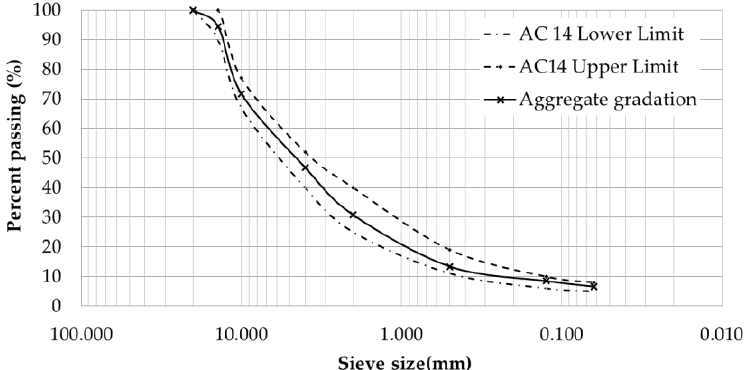
Figure 1. Aggregate gradation of the asphalt concrete with an aggregate size of 14 mm (AC 14) mixture.